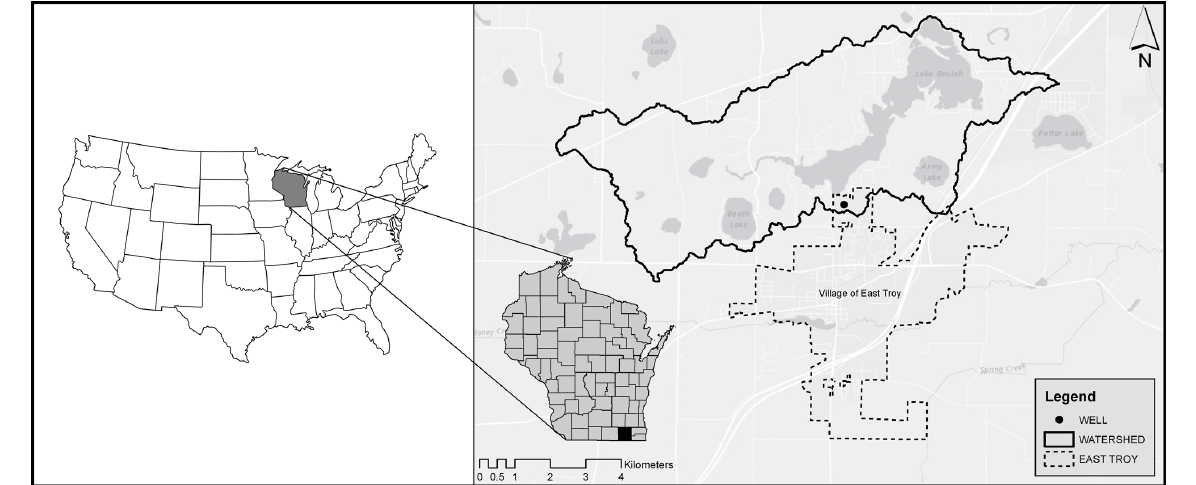
Fig. 1 . Geographical perspective of the Lake Beulah / East Troy